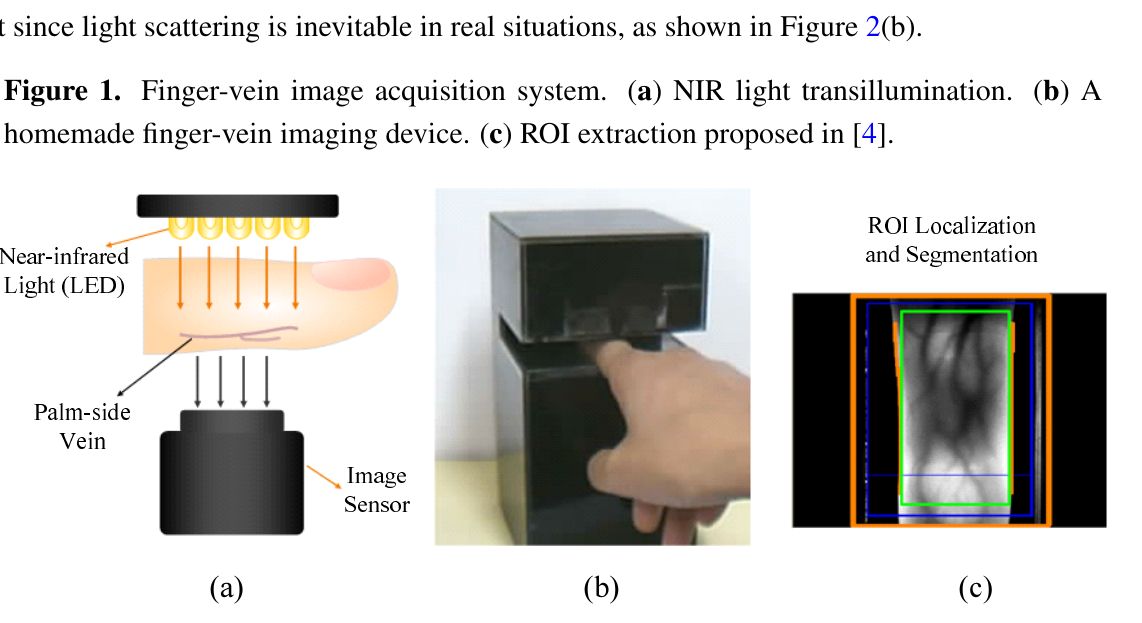
Figure 2. Image contrast reduction due to light scattering. ( a ) A real shadow as no light scattering. ( b ) A degraded shadow as light